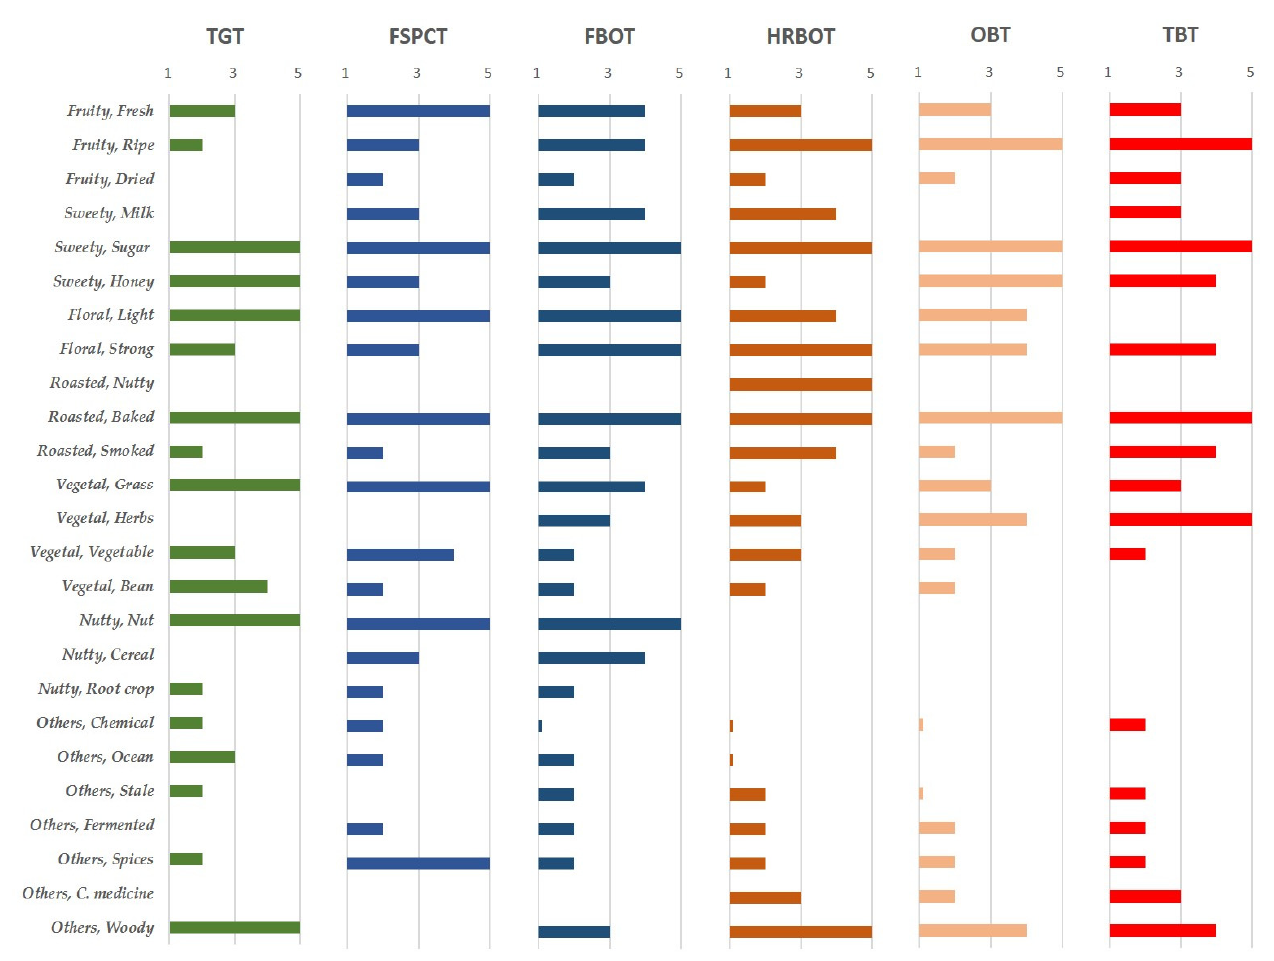
Figure 5. Profiling the acceptance index of the consumers’ sensory perception of the aroma attributes of each flavor wheel. A 5-point scale is used for the acceptance index of the horizontal axis.